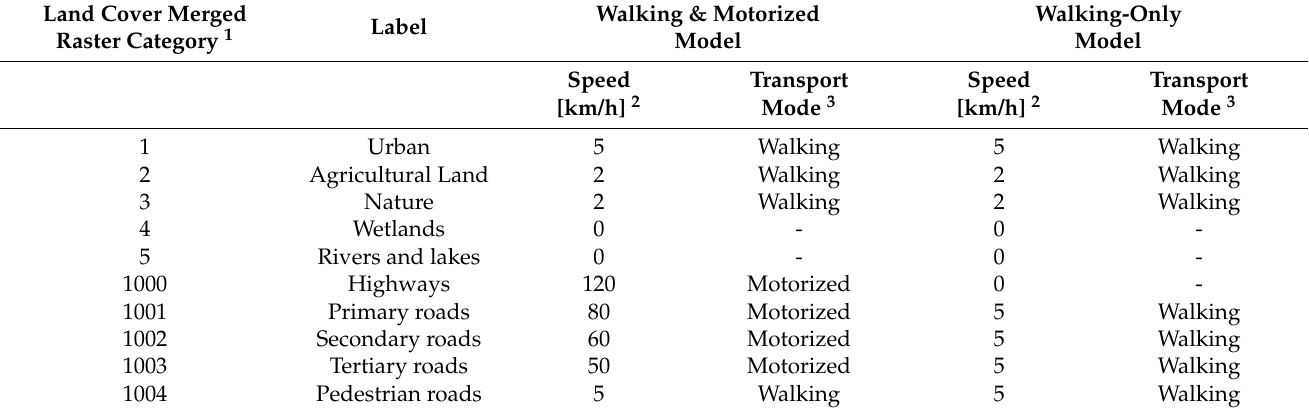
Table 2. Description of the travel scenarios, with speeds and transport modes for each merged landcover categories. Land Cover Merged Raster Category